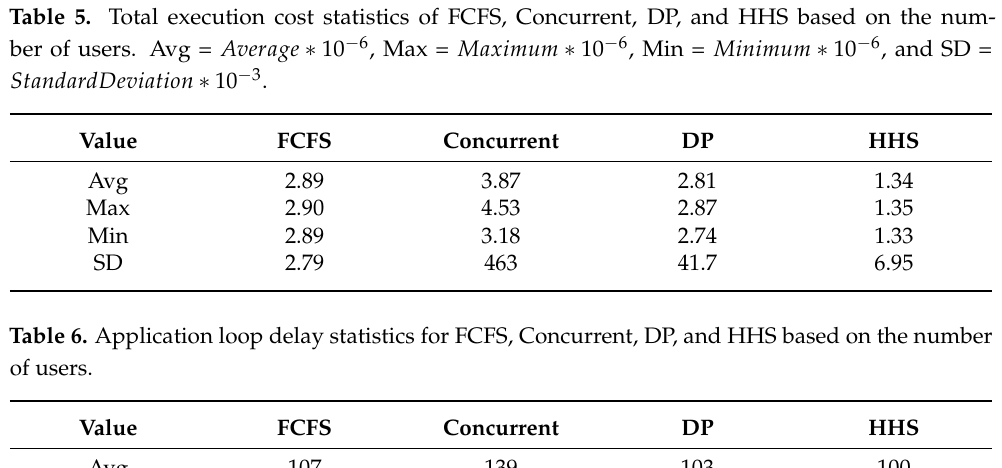
Table 5. Total execution cost statistics of FCFS, Concurrent, DP, and HHS based on the num-